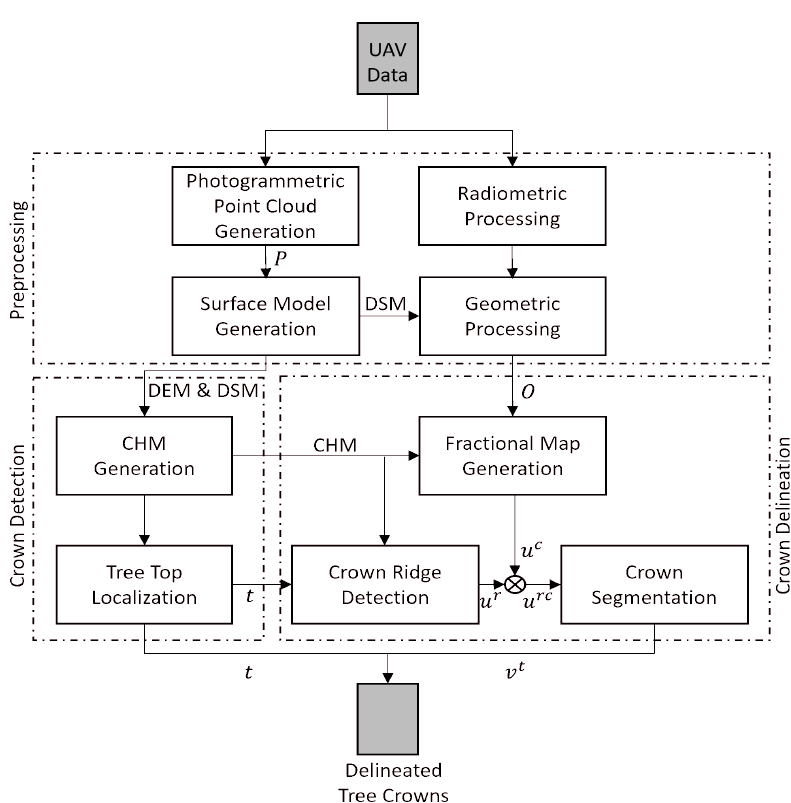
Figure 2. Block scheme of the spectral, spatial-contextual, and structural information-based indi- vidual tree crown delineation method (S3-ITD), crown detection, and delineation method for VHR multispectral data. The geometric and radiometric corrections of the VHR data are performed using the photogrammetrically derived digital surface model (DSM) and the known reflectance panel parameters, respectively. The set of treetops t corresponding to local maxima in the canopy height model (CHM) are detected using the local maxima detection (LM) algorithm. The crown-fractional map ( u c ) generated using the Markov random field based spatial-contextual model (FCM-MRF) classifier is integrated with the ridge map ( u r ) obtained using the marker-controlled watershed segmentation in order to derive the ridge-integrated fractional map ( u rc ). Spruce crown delineation is achieved by performing region growing on the ridge-integrated fractional map ( u rc ) using the gradient vector field (GVF) snake